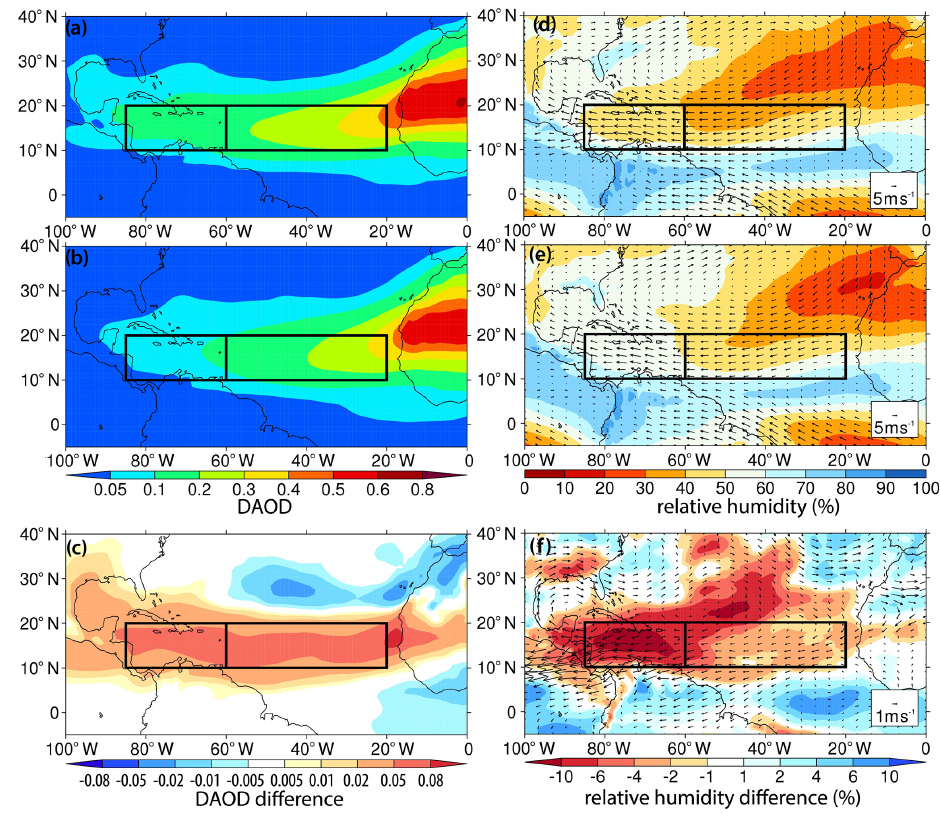
Figure 6. (a, b, c) MRC JJA composite of DAOD for the three Atlantic hurricane seasons from 2003 to 2018 with (a) the highest JJA Caribbean DAOD (2014, 2015, and 2018), (b) the lowest JJA Caribbean DAOD (2005, 2011, and 2017), and (c) the difference between the two (highest minus lowest). (d, e, f) the corresponding JJA composite of 850hPa wind (vectors) and 700hPa RH (color